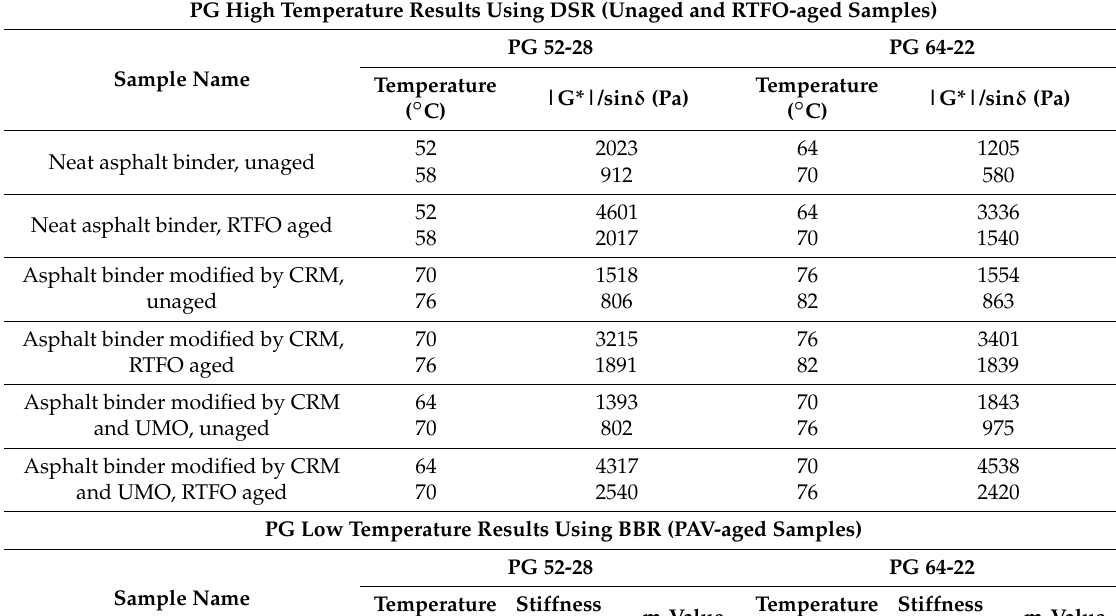
Table 2. PG values for neat and modified asphalt